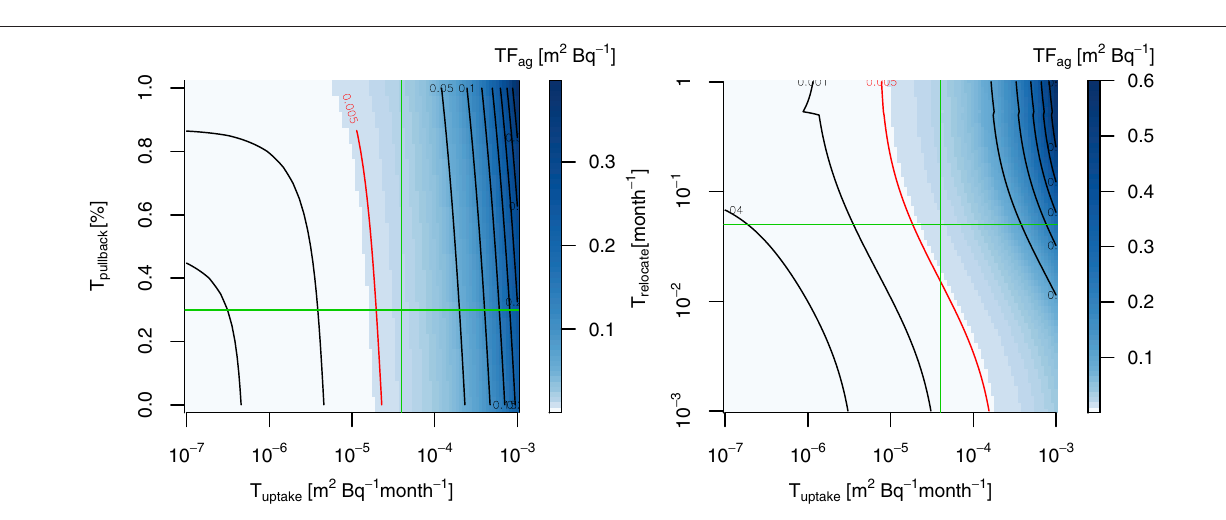
in the canopy, we used the values of the 137 Cs inventory and activities for 30 years after the fallout event to estimate TF ag